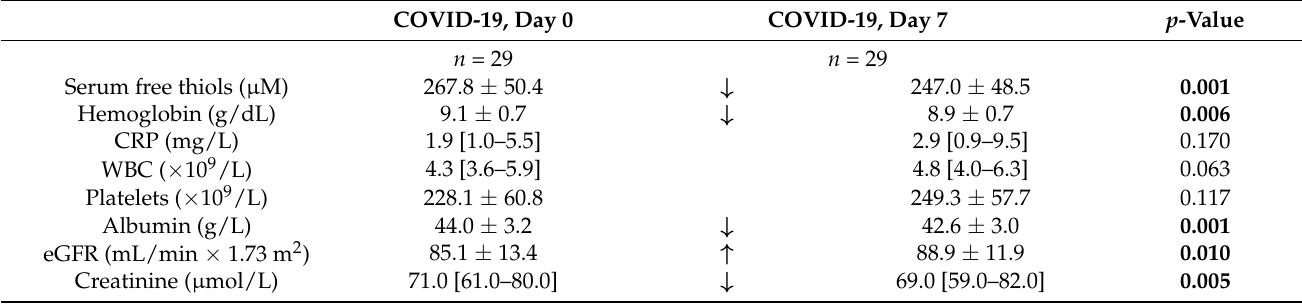
Table 3. Serum free thiol concentrations and other laboratory measurements in mild COVID-19 subjects at different time points.